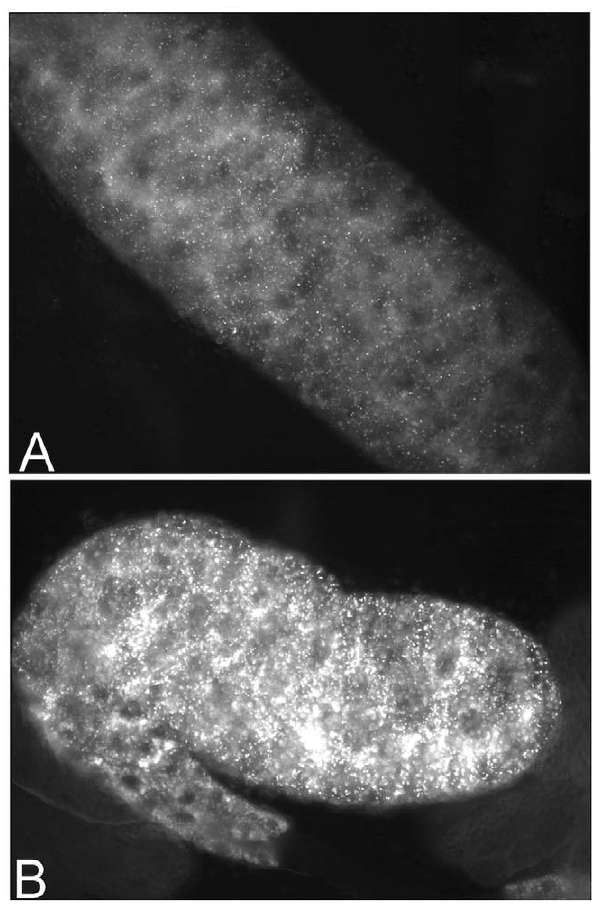
Figure 6. Dietary chloroquine impairs lysosome-mediated proteolysis. Salivary glands were dissected from LAMP1-GFP-express- ing third instar larvae that were fed for 36 hr on instant Drosophila food reconstituted with water (A) or 10 mM chloroquine (B). Increased GFP fluorescence in the salivary glands of chloroquine-fed larvae results from both larger and brighter fluorescent vesicles.